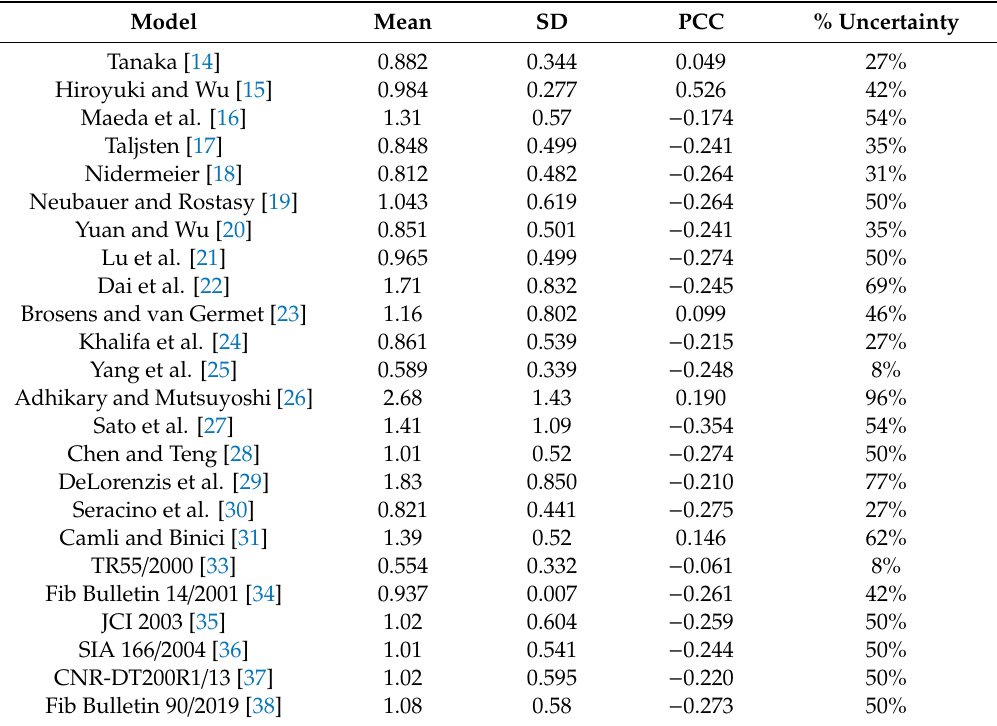
Table 6. Summary of results—predicted to experimental bond strength ratios for steel-reinforced grout (SRG) composites bonded to